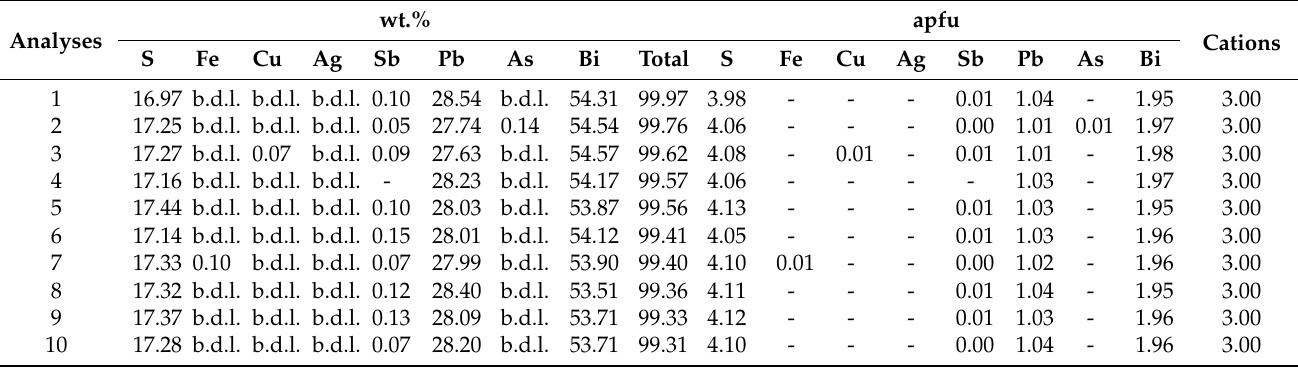
Galenobismutite occurs as euhedral or subhedral crystals up to 300 µ m in size, asso- ciated with bismuthinite (Figure 16e). The chemical composition of galenobismutite and the corresponding chemical formulae are given in Table 8. The chemical composition of galenobismutite is close to the ideal formula; only traces of Sb (up to 0.17 wt.%) and As (up to 0.14 wt.%) were identified. The generalized formula based on 3 cations can be expressed